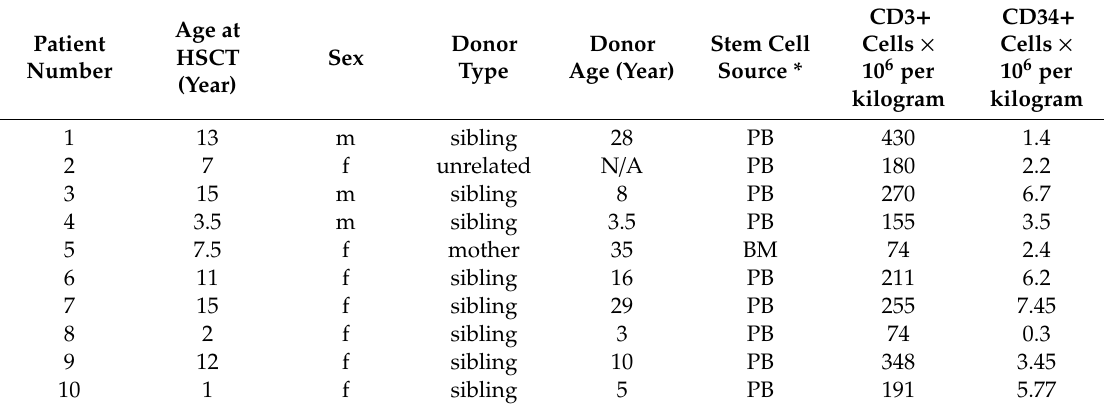
Table 1. Characteristics of the patients and